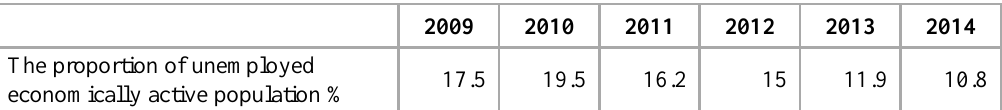
Table 1. Unemployment Rate in Latvia (%) during the period from 2009–2014. Data source: Central Statistical Bureau of